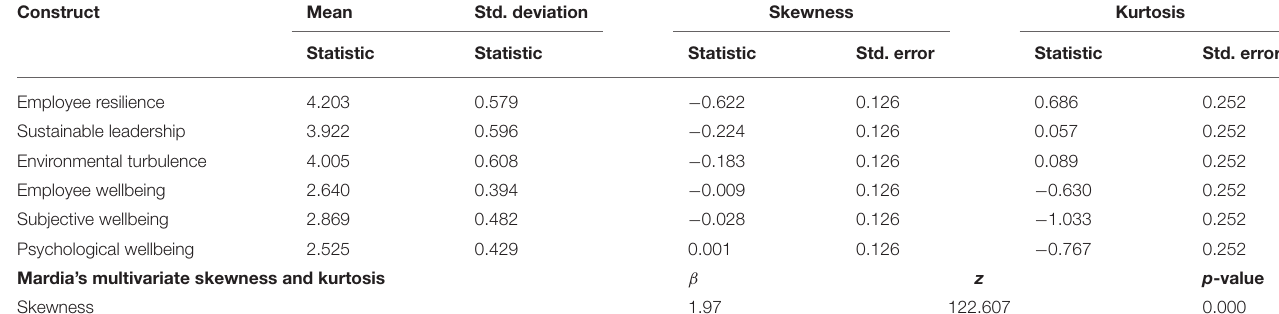
TABLE 1 | Descriptive statistics and normality of data. Construct